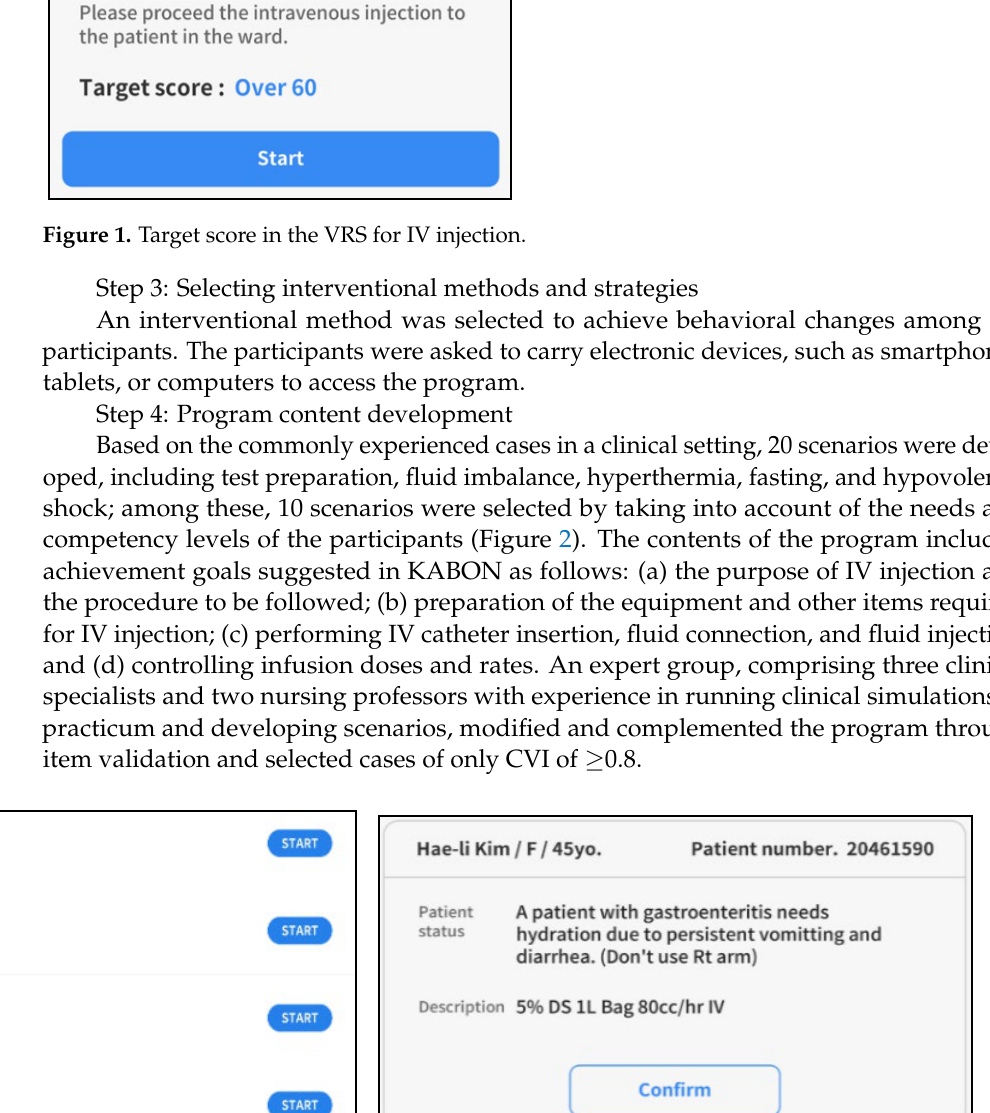
Figure 1. Target score in the VRS for IV injection.